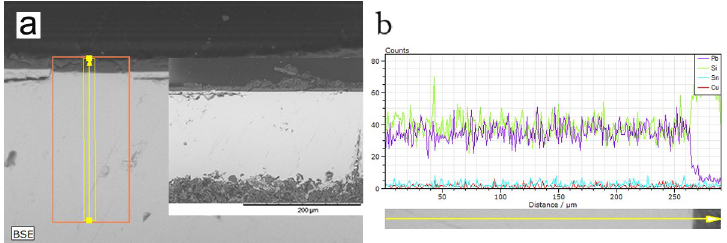
Fig 4. The test area and results of sample No. 23 glaze. ( a) Linear test area of the glaze in sample. (b) Linear variation of the glaze elements in sample.